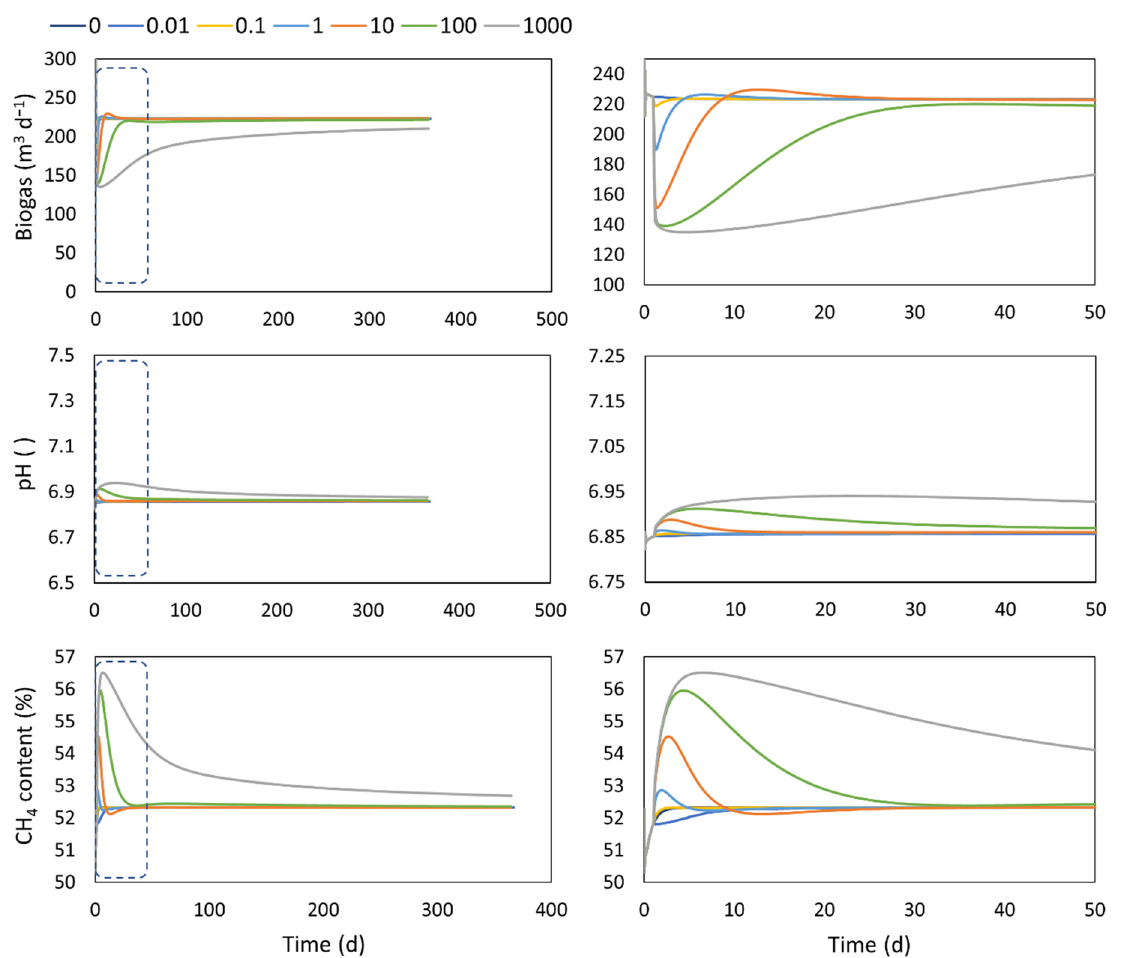
Figure 4. Performance of a digester during start-up with different inoculum characteristics. Left : results of a year of operation. Right : zoom in on the first 50 days of operation.